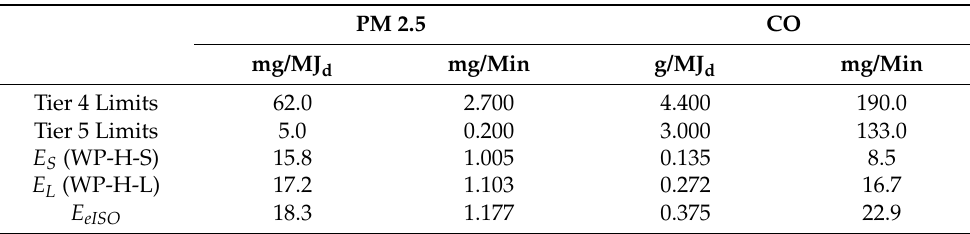
Table 5. Emission limits according to ISO 19867-3:2018 [20], input and output values for approxima- tion of a theoretical ISO-compliant measurement. PM